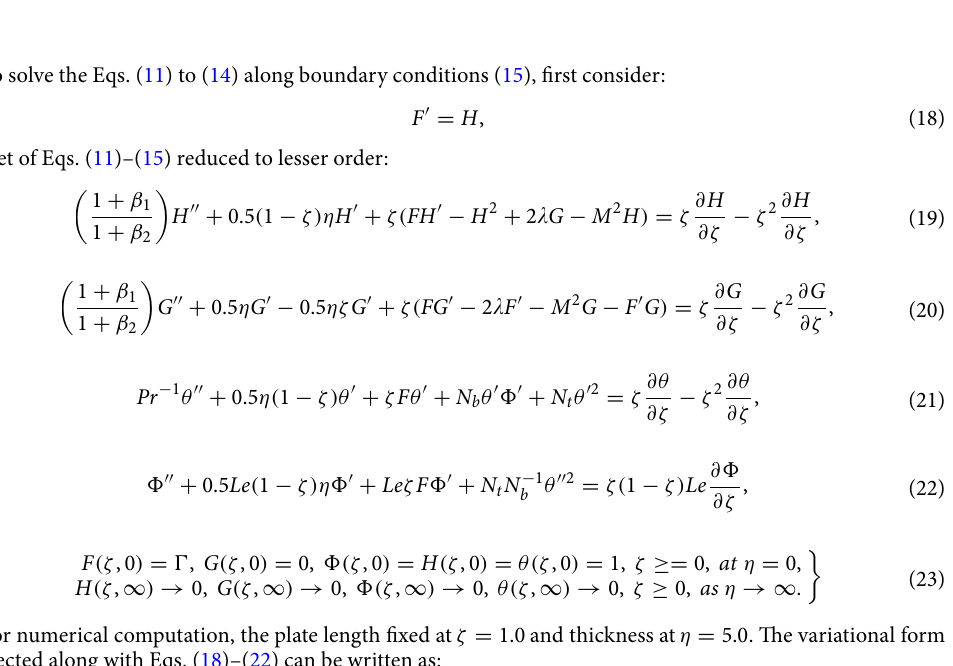
Table 3. Comparison of Nusselt number other parameters are